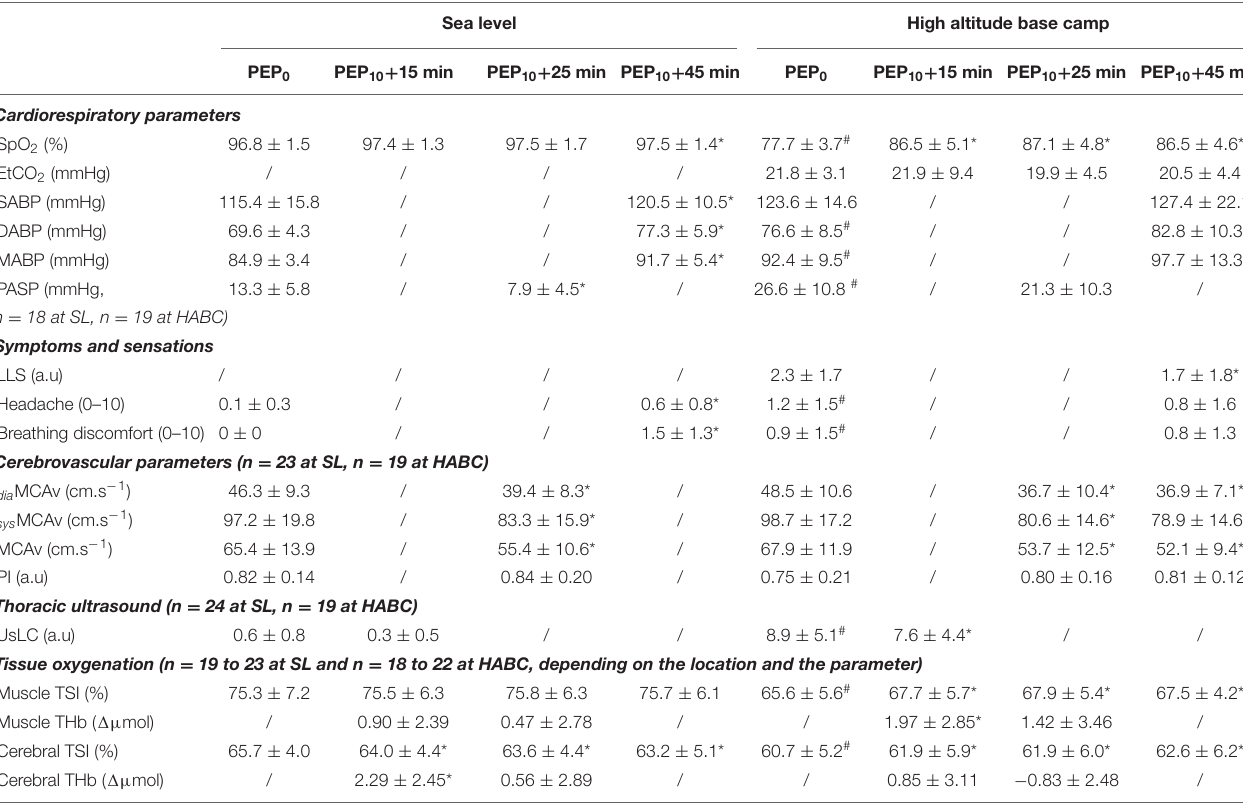
TABLE 1 | Changes in cardiorespiratory data, subjective feelings and cerebrovascular and tissue oxygenation parameters while breathing with PEP 0 and PEP 10 at sea level and at high altitude base